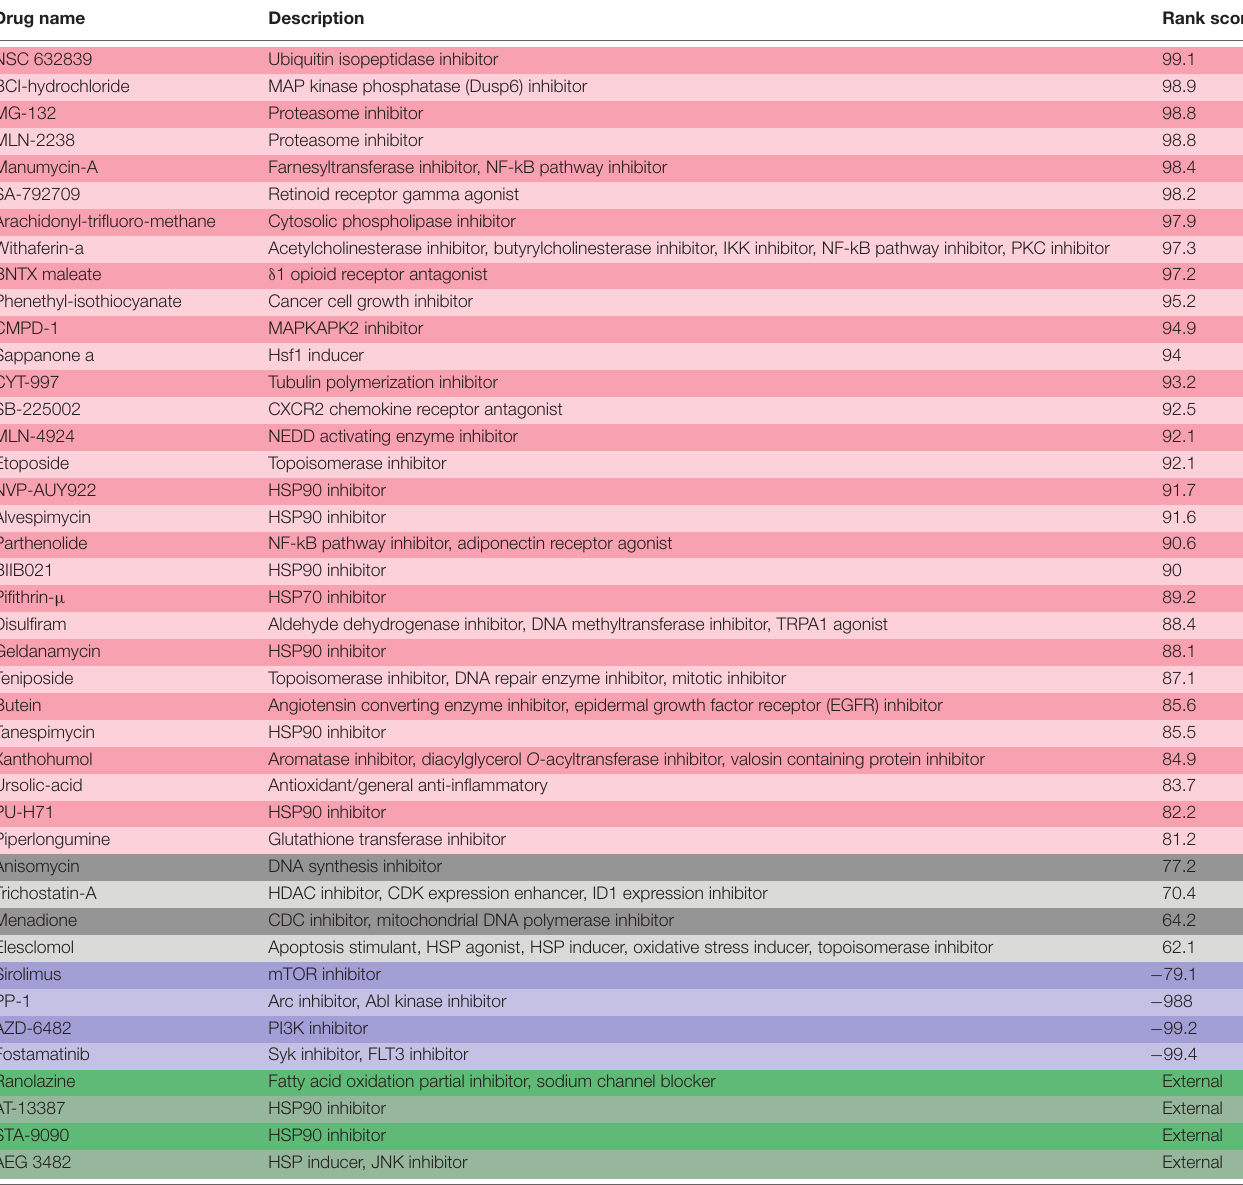
TABLE 4 | A detailed list of the 42 compounds chosen for otoprotection screening identified in Figure 3B